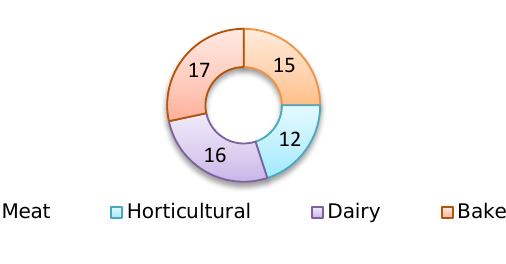
Figure 1. Distribution of companies by subsector (Gaspar et al., 2018).